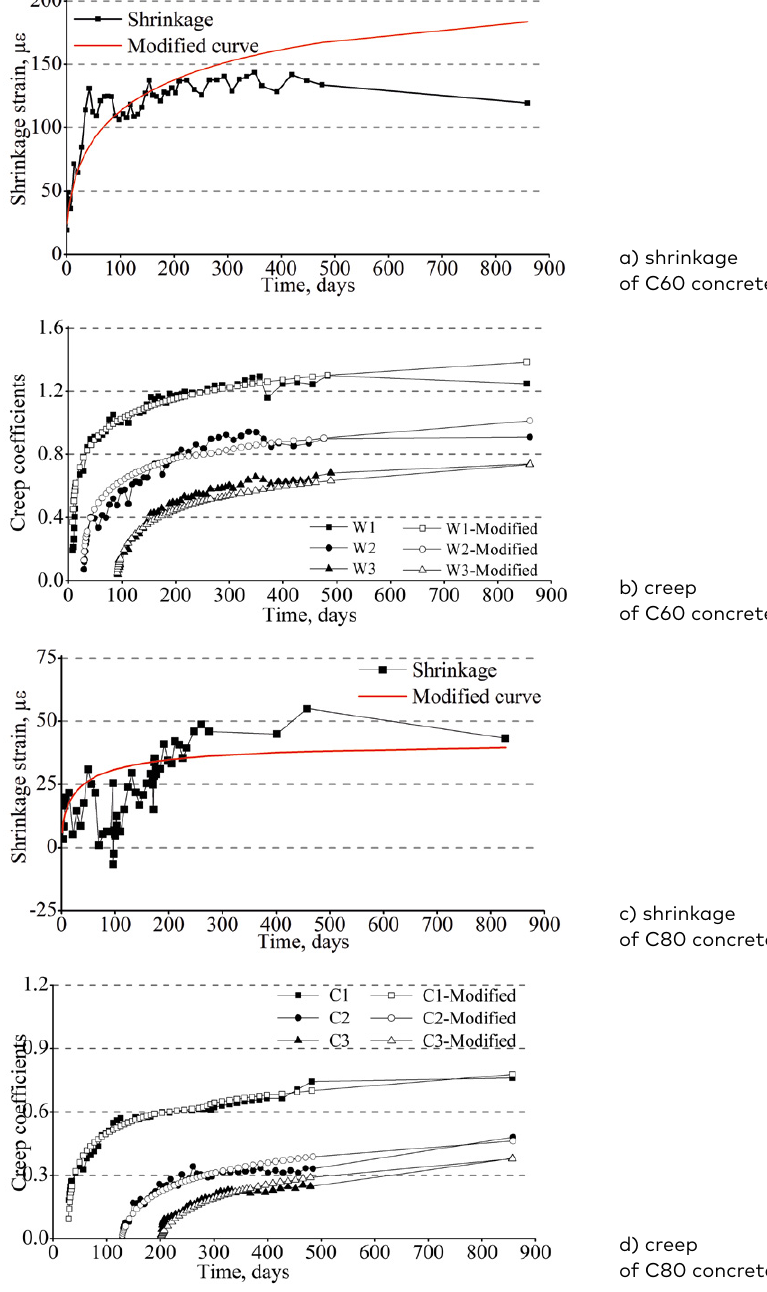
Figure 10. Predicted shrinkage and creep curves from modified